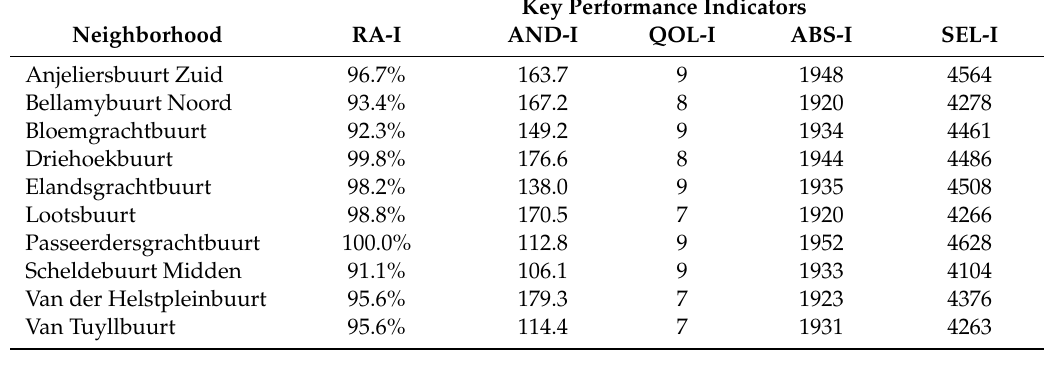
Table 6. KPIs of the ten template neighborhoods. Key Performance Indicators